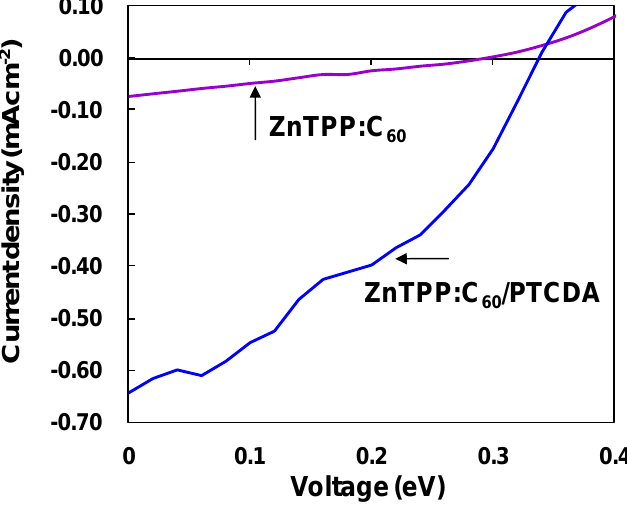
Figure 2. Measured J-V characteristic of ZnTPP:C under illumination.